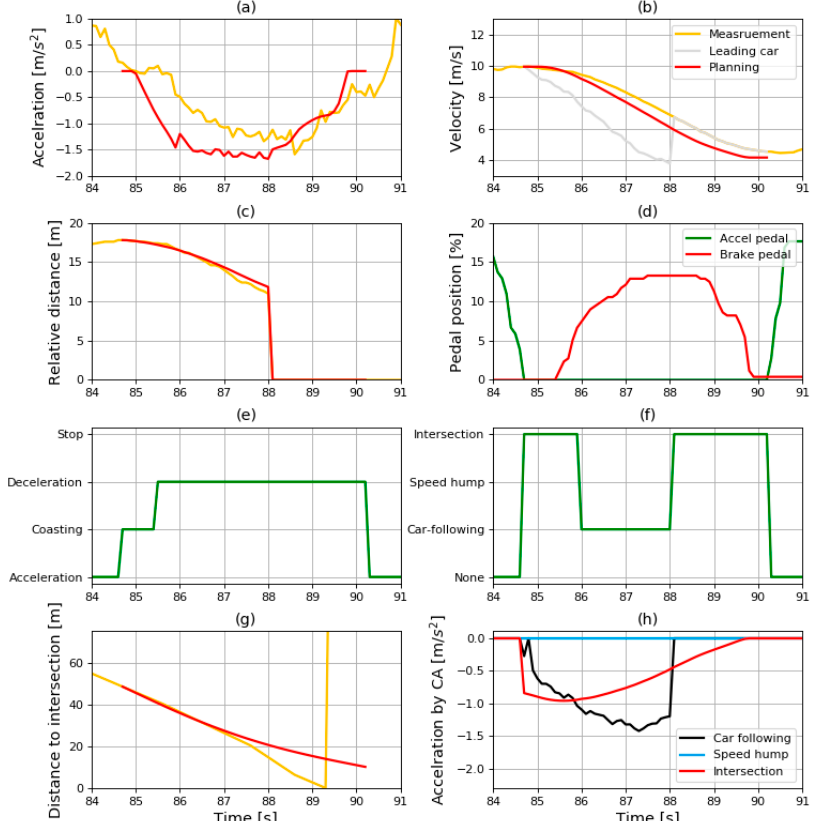
Figure 19. Sliced results of ( a ) acceleration; ( b ) velocity; ( c ) relative distance; ( d ) pedal position; ( e ) driving state; ( f ) deceleration condition; ( g ) distance to intersection; ( h ) and acceleration by CA model in intersection condition. Table 5. Root-mean-square error (RMSE) of velocity in each sliced